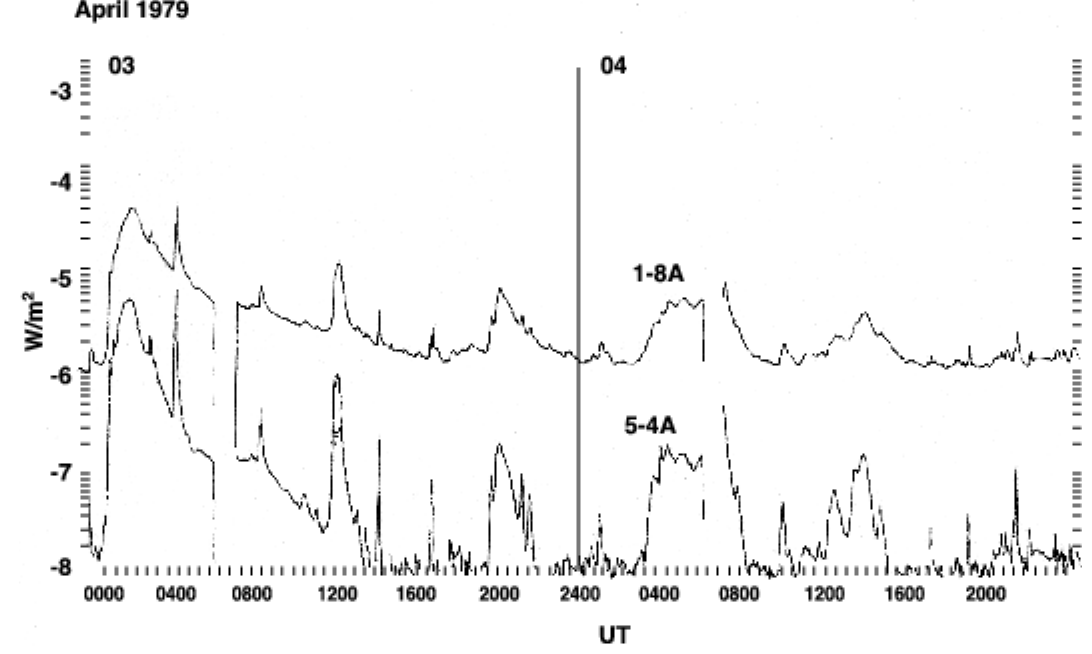
Fig. 4. SMS-GOES 8 measurements of soft X-rays in 2 wavelengths on 3–4 April 1979.